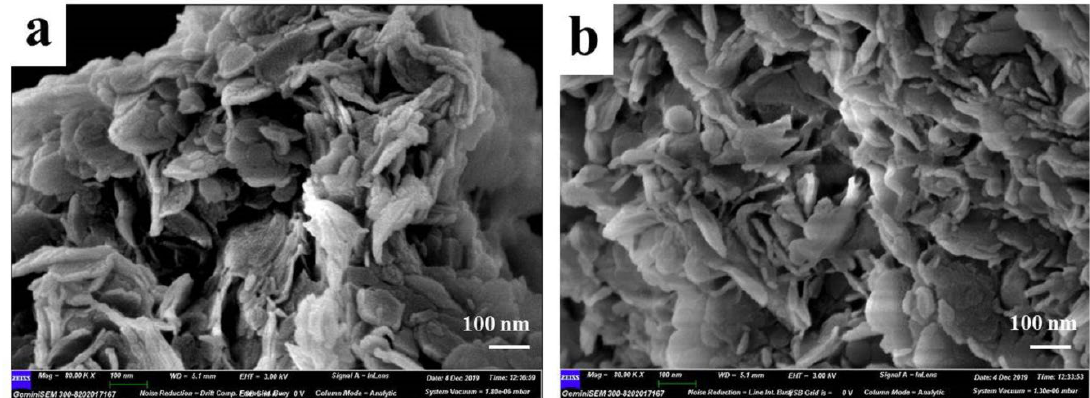
Figure 3. SEM images of ( a ) TM LDHs and ( b ) QM LDHs.